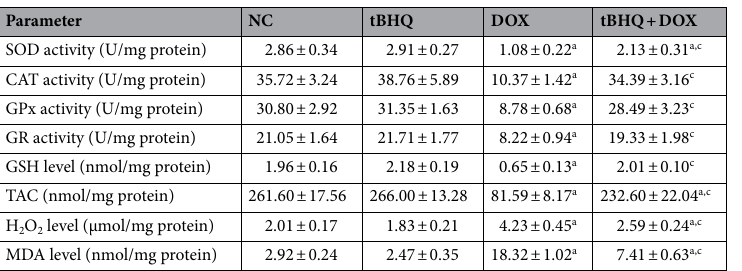
Parameter NC tBHQ DOX tBHQ + DOX